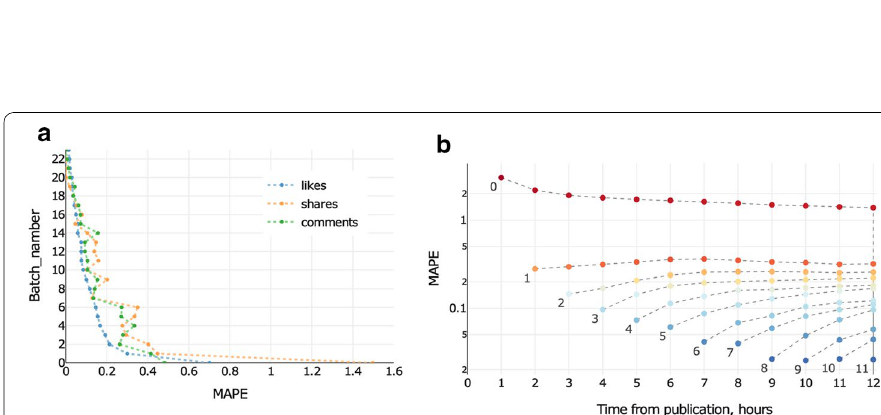
Fig. 9 Forecast accuracy a depending on the batch number, b depending on forecast hours (numbers of lines denote forecast